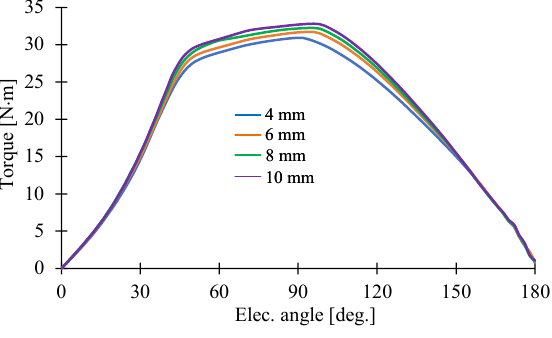
Figure 9. Static torque profiles at a 60 A excitation current for different rotor pole